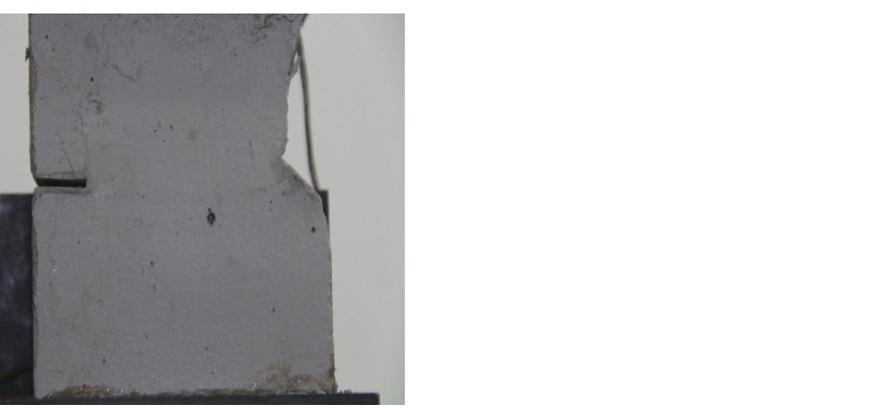
Figure 34. Photograph of a specimen with 20 mm long cracks under uniaxial compression at t = 1984s showing the crack developed at that